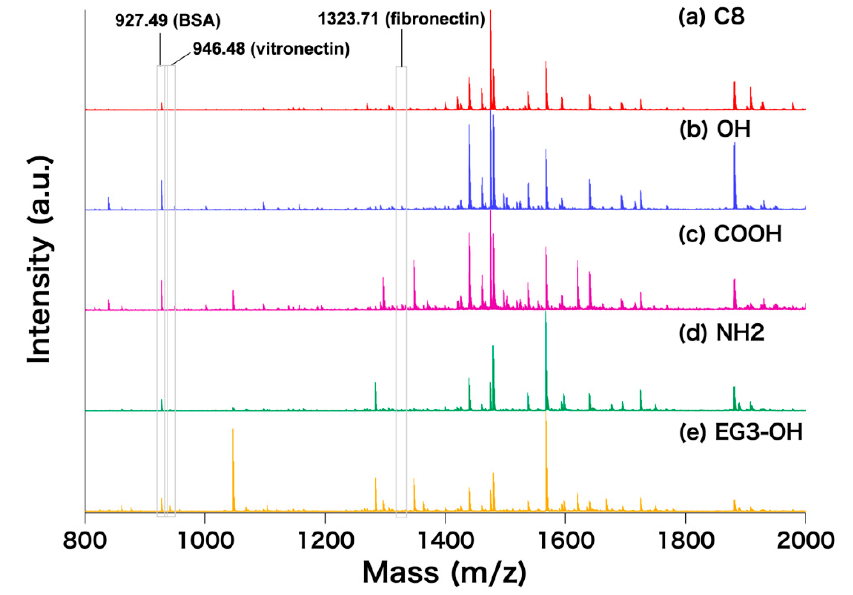
Figure 6. MALDI-ToF mass spectra of fragmented proteins on the SAMs; ( a ) C8, ( b ) OH, ( c ) COOH, ( d ) NH2, and ( e ) EG3-OH SAMs. The locations of the reference m / z of BSA, vitronectin and fibronectin are shown (m / z = 927.49, 946.48 and 1323.71 for BSA, vitronectin, and fibronectin, respectively).